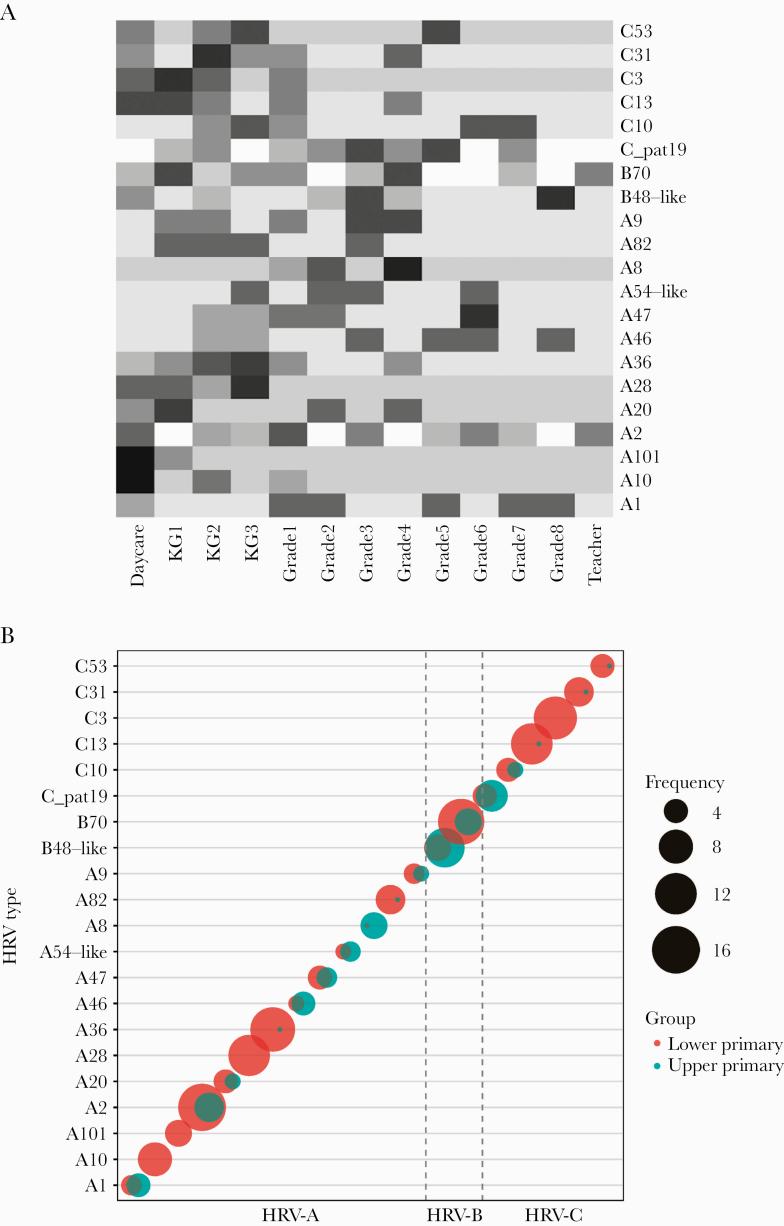
Distribution of genotypes across the school. A, Heatmap showing the distribution of frequent genotypes across the school classes. The intensity of the color correlates to the frequency of samples. Color intensity has been scaled to correct for sampling bias between the lower primary and upper primary classes. B, Distribution of frequent genotypes between the upper and lower primary groups. The sizes of the circles correlate to the number of samples and the color to the respective group: either lower or upper primary. Abbreviation: HRV, human rhinovirus.